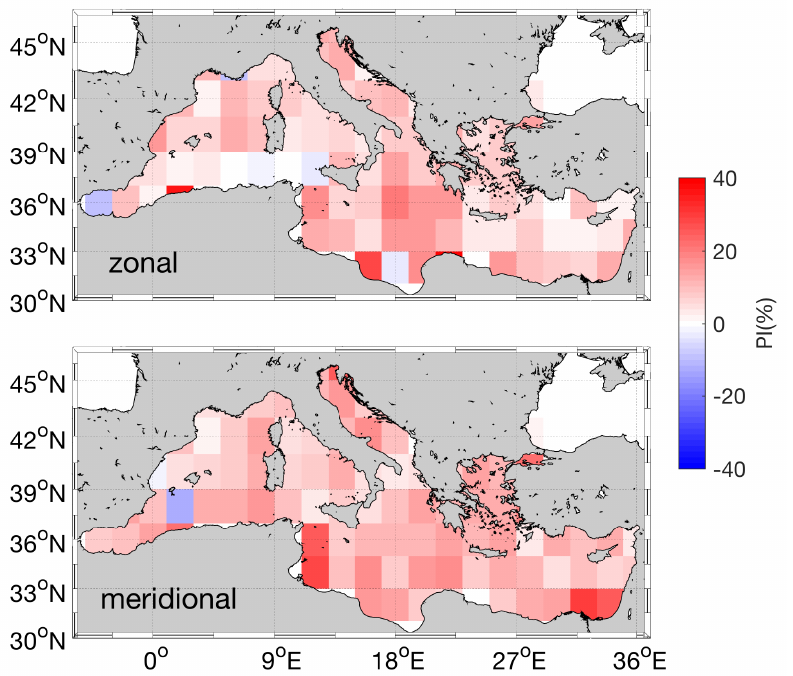
Figure 16. PI of the Optimal Currents given in 2 ◦ × 2 ◦ boxes: ( top ) zonal currents ; ( bottom ) meridional